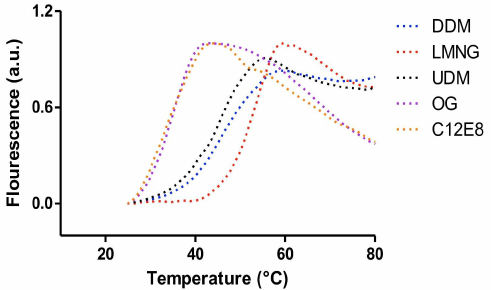
Figure 8. Thermal stability profiles of a membrane protein in the presence of di ff erent detergents using the thiol-specific fluorochrome N-[4-(7-diethylamino-4-methyl-3-coumarinyl)phenyl] maleimide (CPM) dye assay. The calculated melting temperatures (T m ) were determined by fitting the curves to a Boltzmann sigmoidal (Equation (2)). The calculated values are as follows: 45.7 ◦ C in the presence of n-Dodecyl β - d -maltoside (DDM); 50.9 ◦ C in the presence of lauryl maltose neopentyl glycol (LMNG); 43.4 ◦ C in the presence of n-Undecyl- β - d -Maltopyranoside (UDM); 32.2 ◦ C in the presence of n-Octyl- β - d -Glucoside (OG); and 34.3 ◦ C in the presence of dodecyl octaethylene glycol ether (C 12 E 8